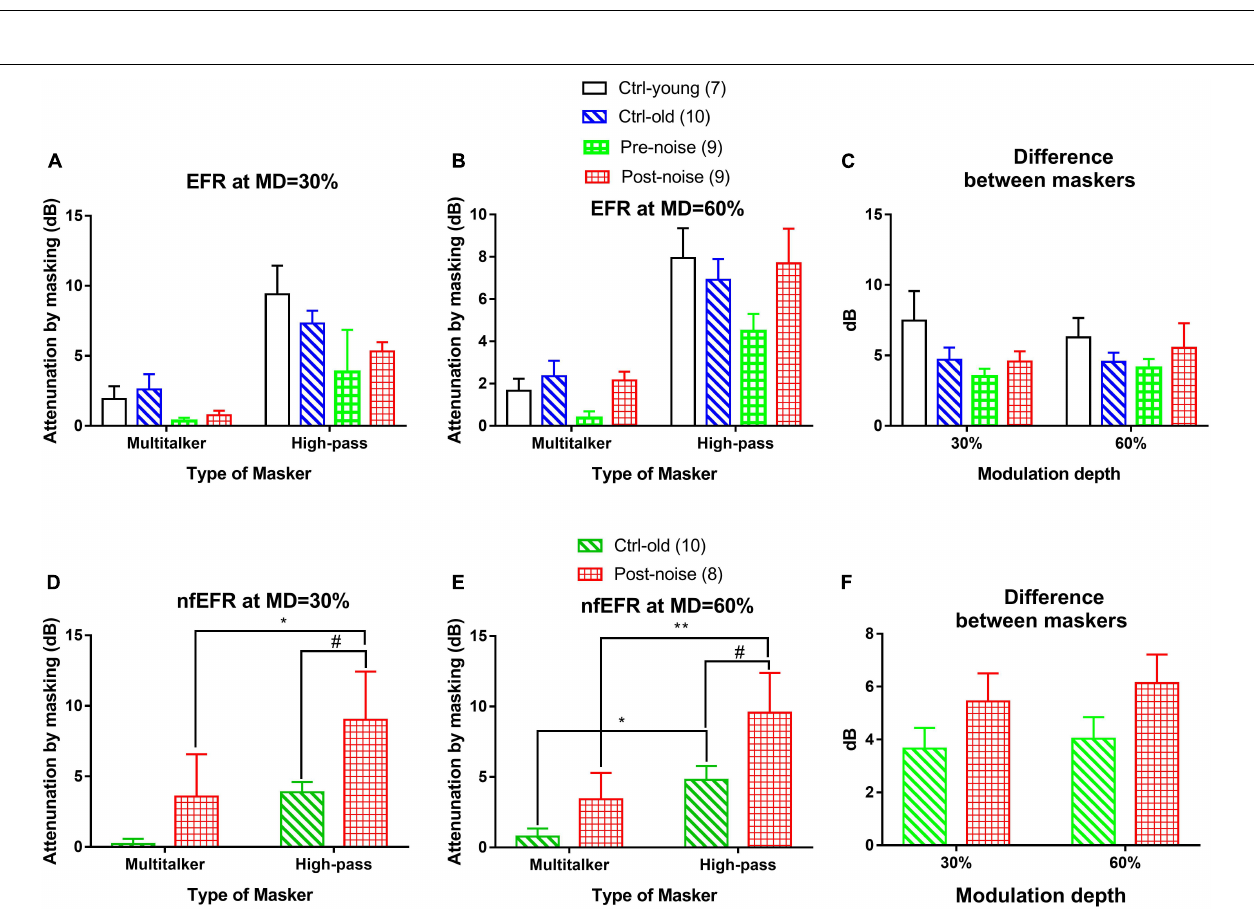
FIGURE 6 | The effect of both the modulated (multi-talker) and stationary (high-pass) maskers at the two MDs [30% (A,D) and 60% (B,E) ] for both the EFR (A,B) and nfEFR (D,E) , as well as the difference in the masking effect between the two maskers [ (C) for EFR and (F) for nfEFR]. Overall, the high-pass noise produced more masking than the multitalker noise. No significant difference was seen between the two maskers with respect to EFR amplitude (C) . For the nfEFR, the HP noise resulting in a greater masking effect for the post-noise group than for the control [# in (D,F) ]. The difference between the two maskers in nfEFR (F) was much larger in the noise group as seen in the two-way ANOVA. However, post hoc tests found no significant differences within each MD. The number of “*” symbols show the significance level of the post hoc comparisons within each group, while the number of “#” symbols show the significance level of the post hoc comparisons within each masker: one for p < 0.05, two for p < 0.01, and three for p < 0.001.